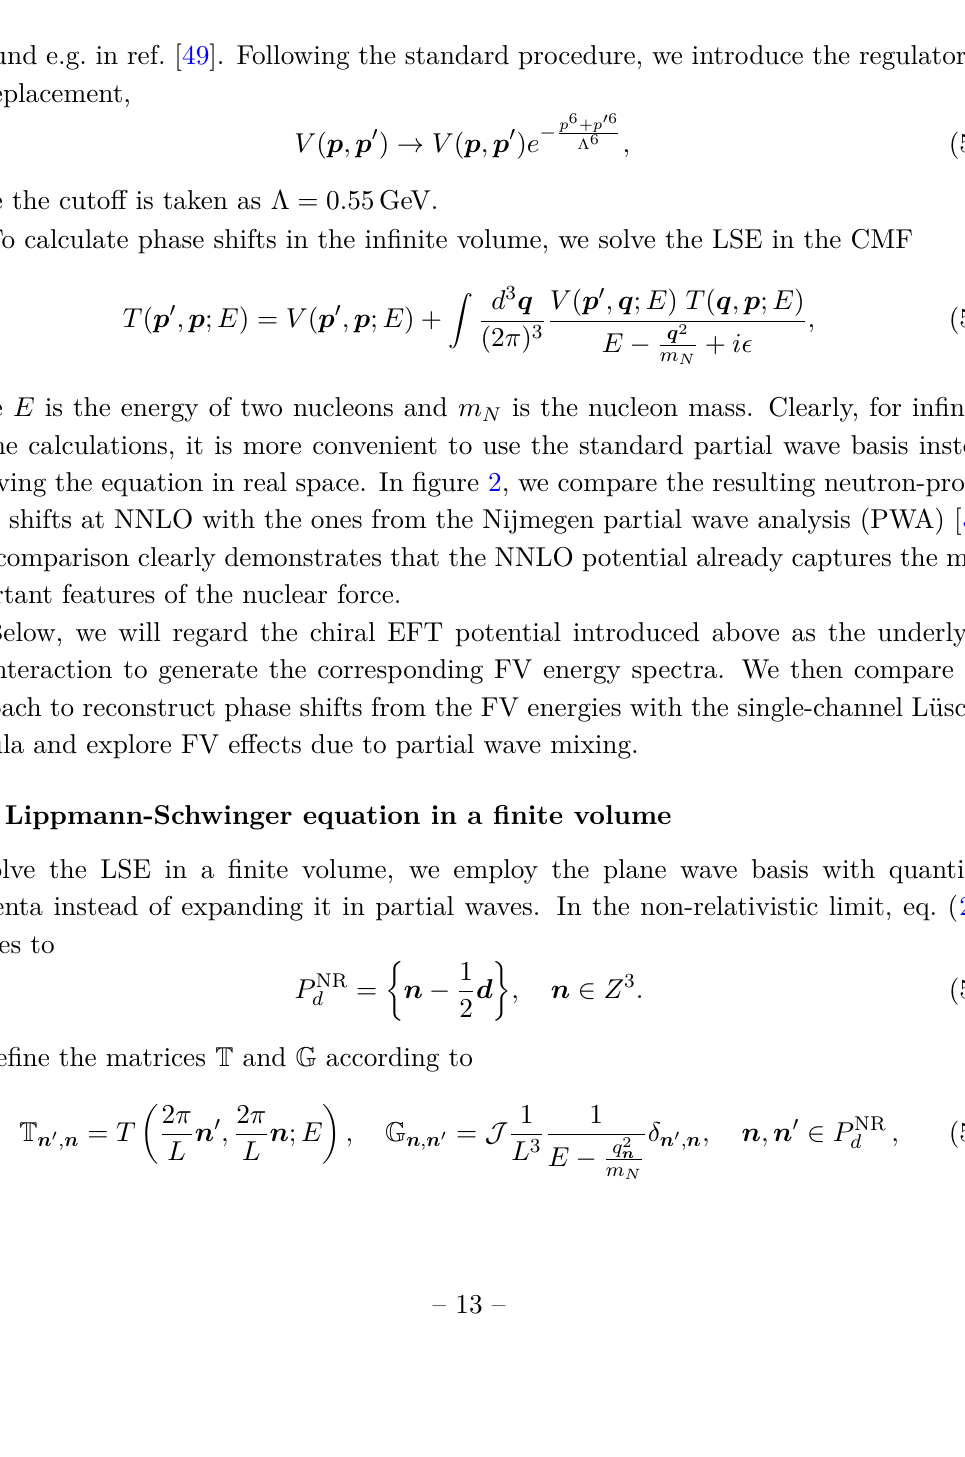
Figure 2 . Spin-singlet NN phase shifts as functions of the laboratory energy. The results of Nijmegen PWA are shown by filled circles [53]. Solid lines correspond to the NNLO chiral EFT results [49,